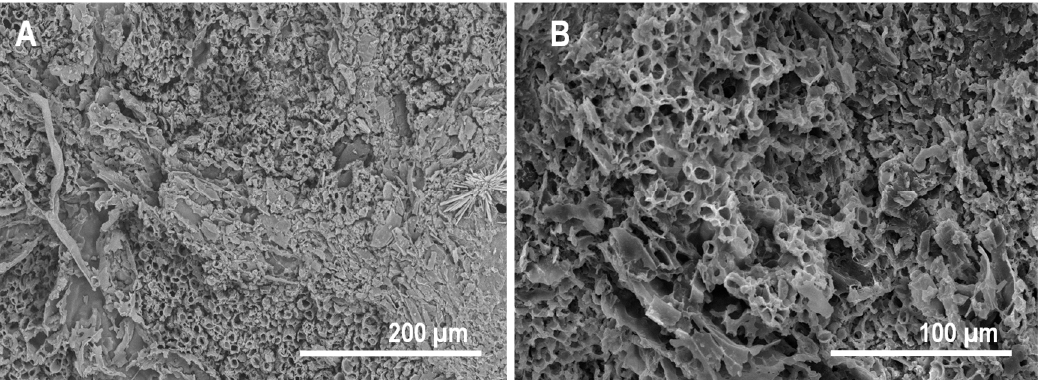
Figure 12. SEM images of the fossil fern Weichselia reticulata (Stokes et Webb) Fontaine from Las Hoyas (Lower Cretaceous of Cuenca, Spain). ( A ) Starred precipitates and fungi-like filaments over the fossil. ( B ) Exceptionally well-preserved internal tissue. Sometimes, the material is charcoalified, showing the exposure to high temperatures during fossilization.